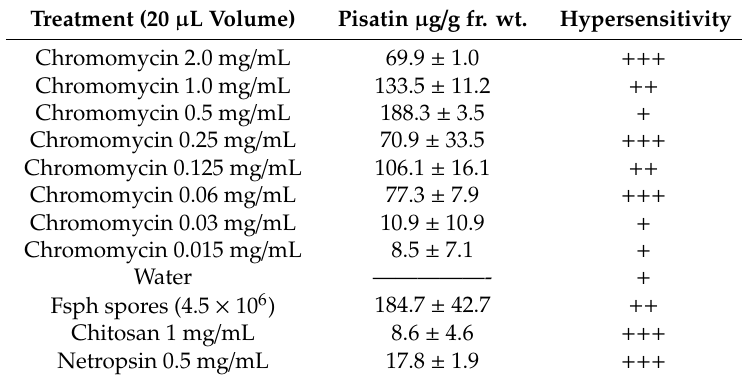
Table 4. Effect of chromomycin on pisatin production. All treatment applications volumes were 20 µ L / pod half. Pisatin accumulations at 24 h were quantitated at UV 309 nm. + indicates the observed